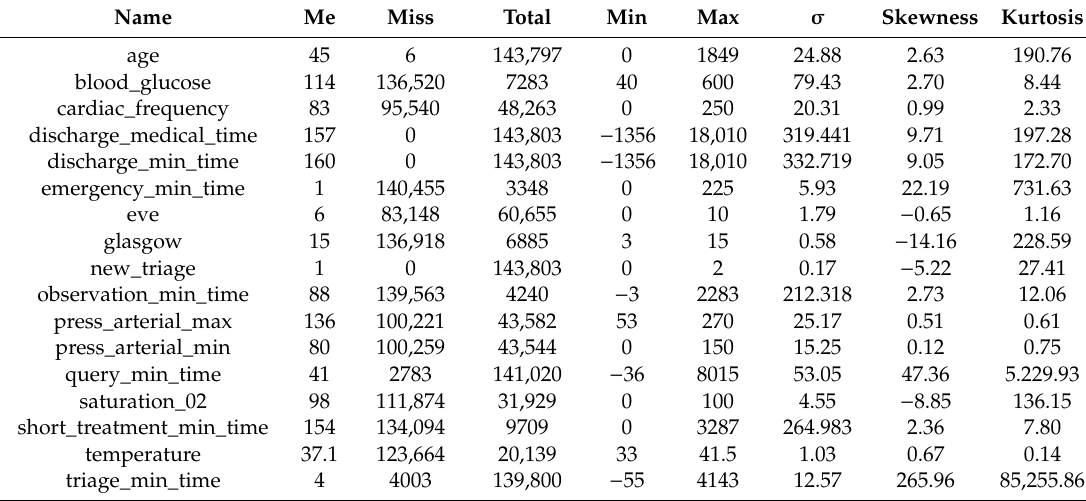
Table 1. Descriptive analysis of the interval variables.